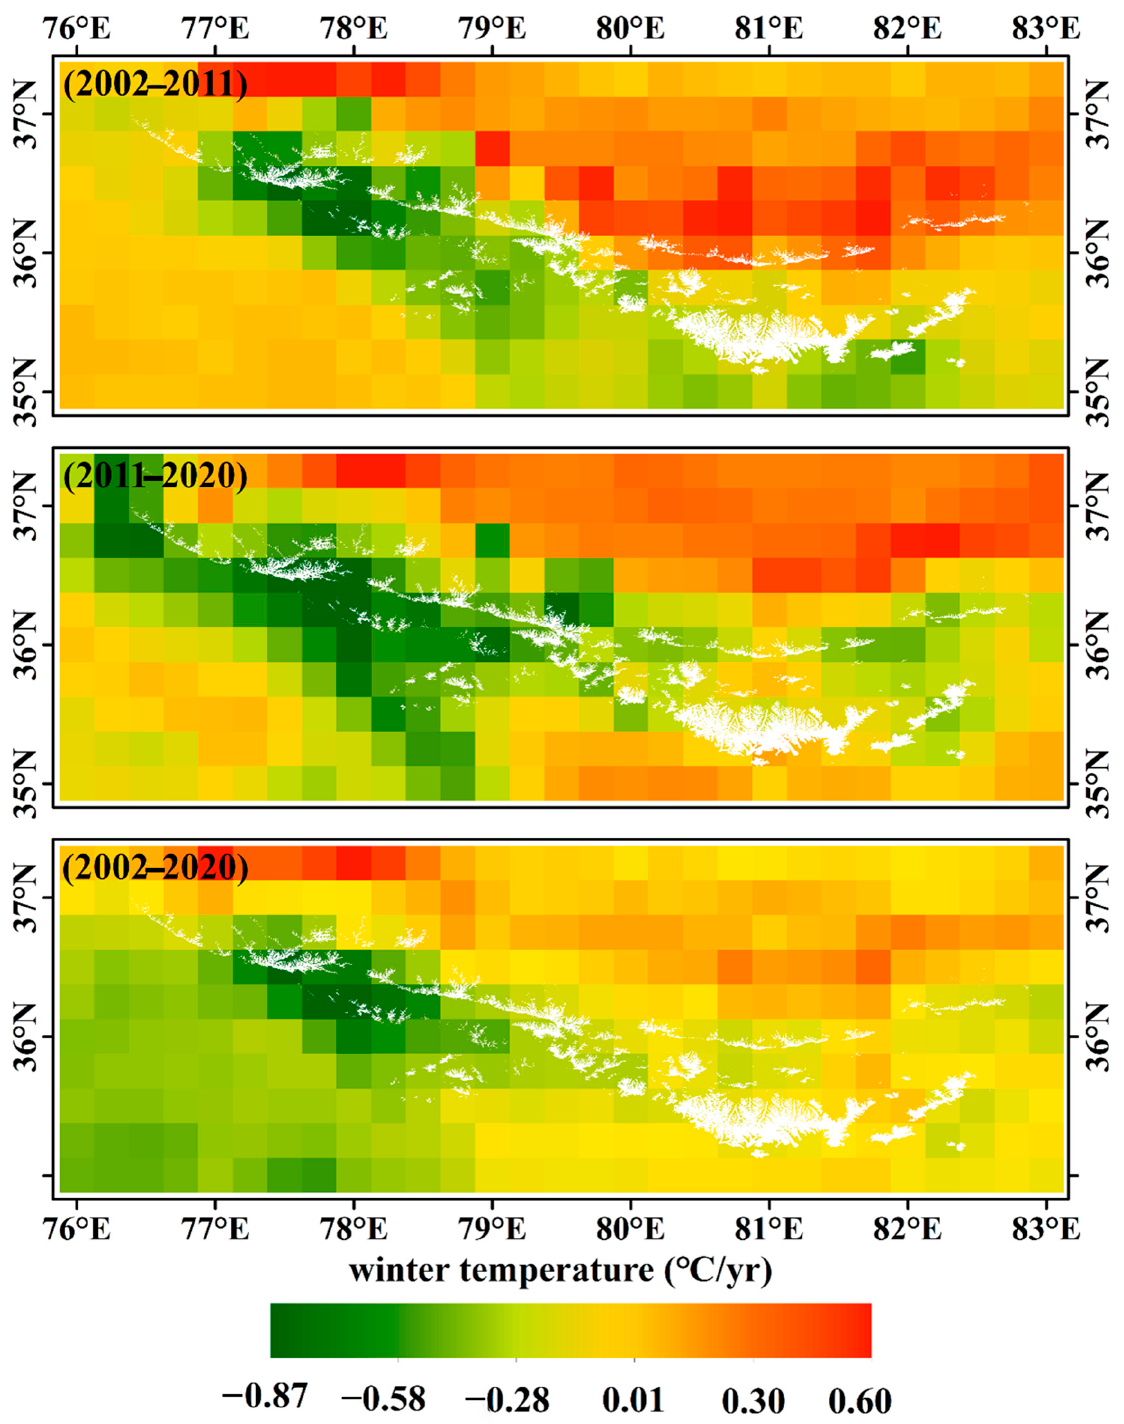
Figure 7. Annual DJF skin temperature trends in WK for 2002–2011, 2011–2020, and 2002–2020, derived from ERA5.1.